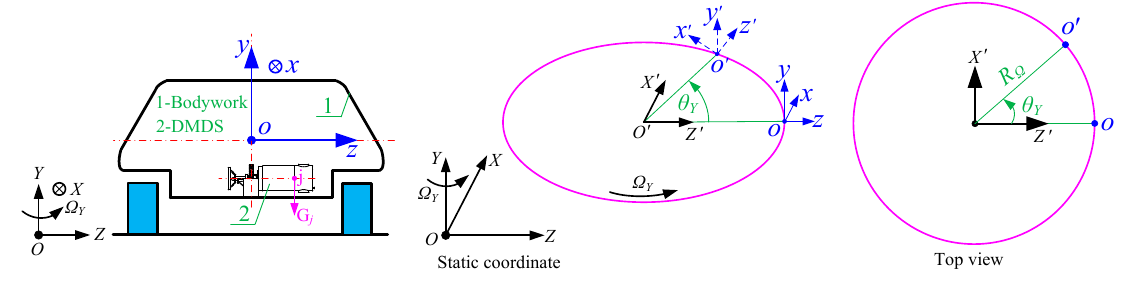
Figure 16. Schematic diagram of circular motion.